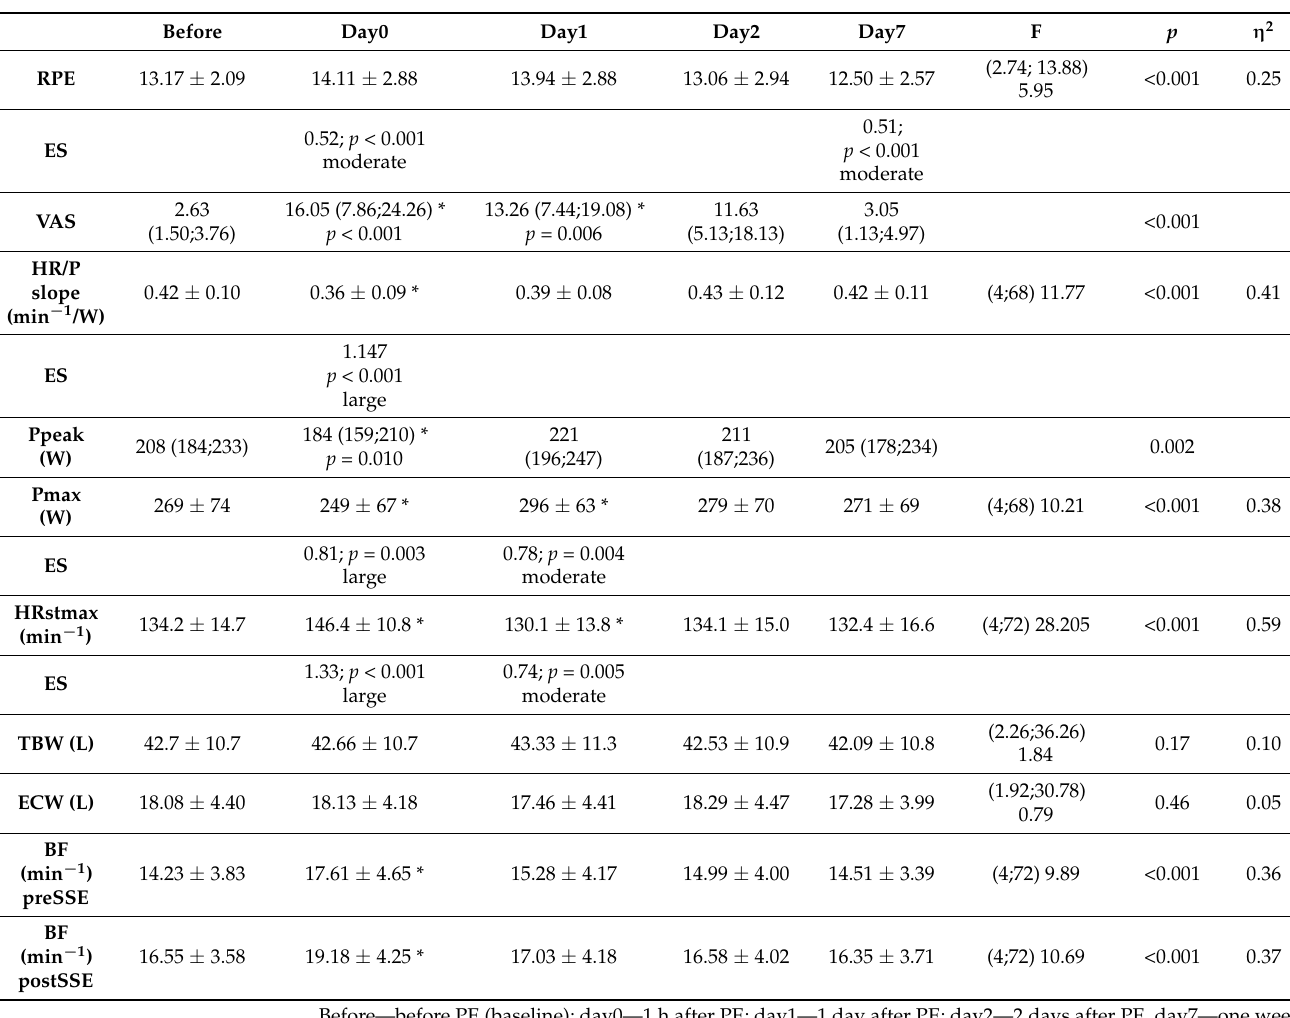
Table 2. Subjective recovery, indices of aerobic performance, hydration, and breathing frequency over